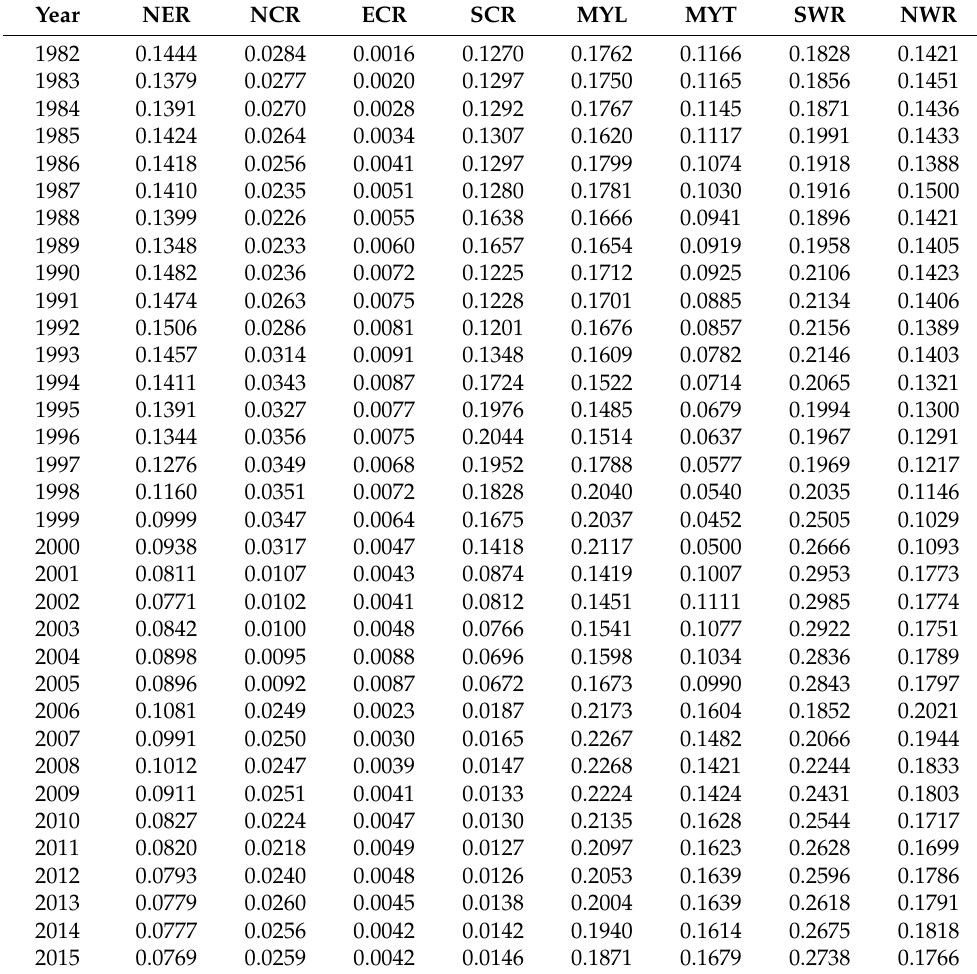
Table A3. The contribution rate of external disparities of each region to the overall